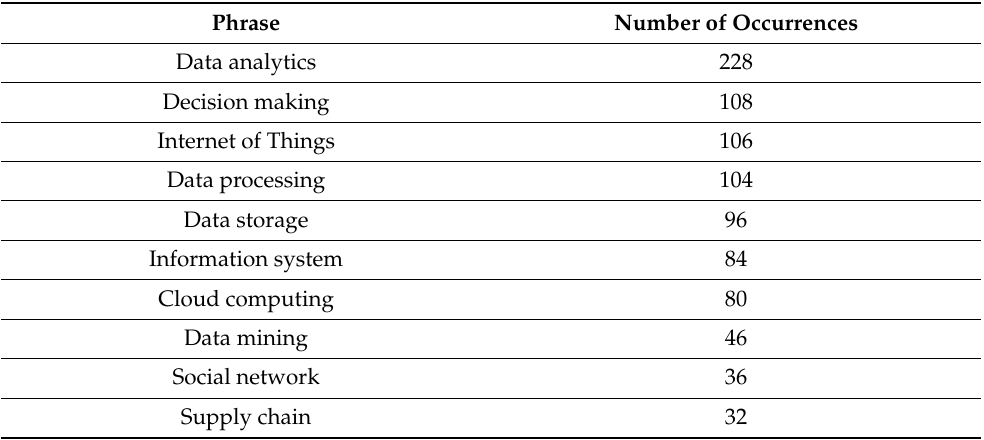
Table 3. Ten most significant phrases related to big-data